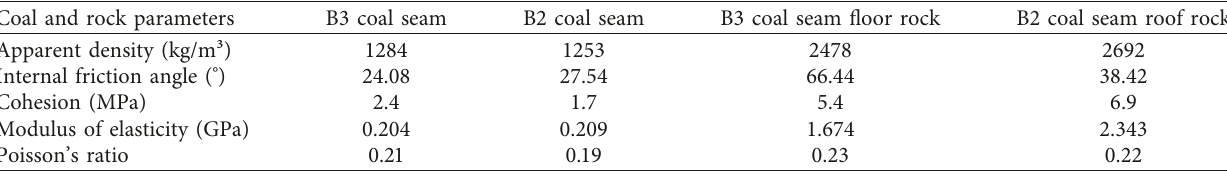
Table 1: Summary of measurement results of physical and mechanical property parameters of +500m horizontal coal and rock samples.